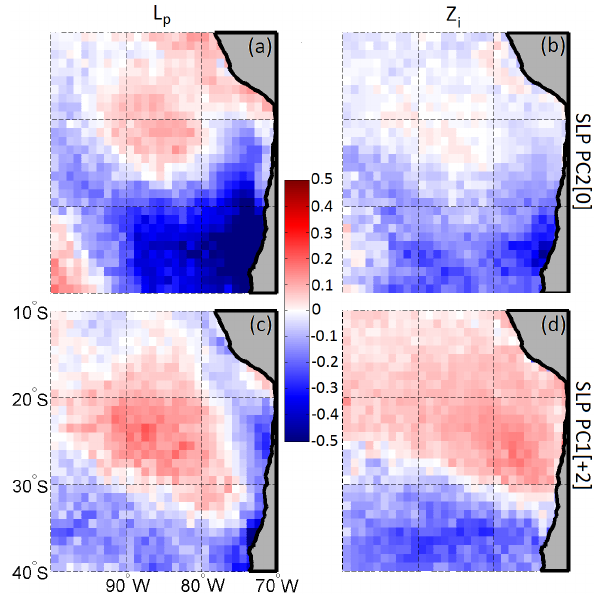
Fig. 11. Fractional composite differences of L p and inversion height, z i , on SLP PC2[0] in the top row. For the most represen- tative comparison the bottom row shows equivalent composite dif- ferences on SLP PC1[+2], as PC1 correlates most strongly with PC2 two days after PC1.